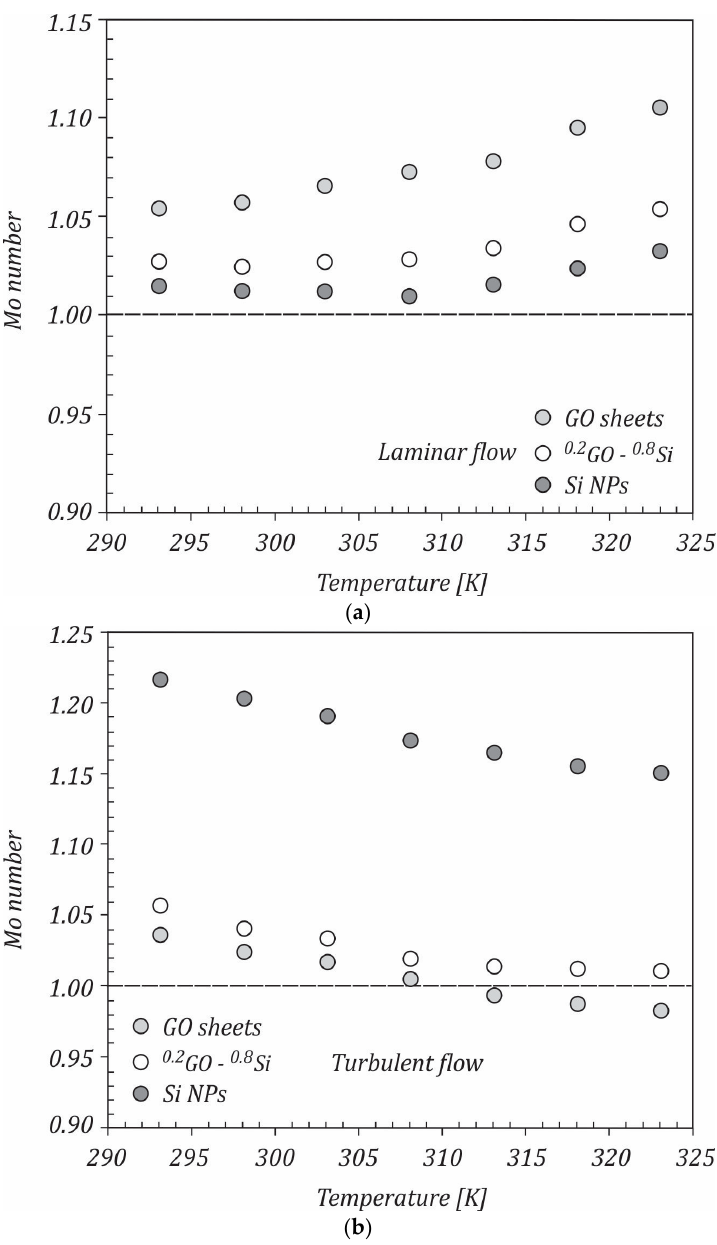
Figure 10. Mouromtseff number in: ( a ) the laminar flow and ( b ) the turbulent flow. To determine the efficiency of the hybrid nanofluids in heat transfer applications under turbulent flow, the heat transfer coefficients ratio was analyzed. According to the Gnielinski correlation [33], the heat transfer coefficient ratio is given by the following